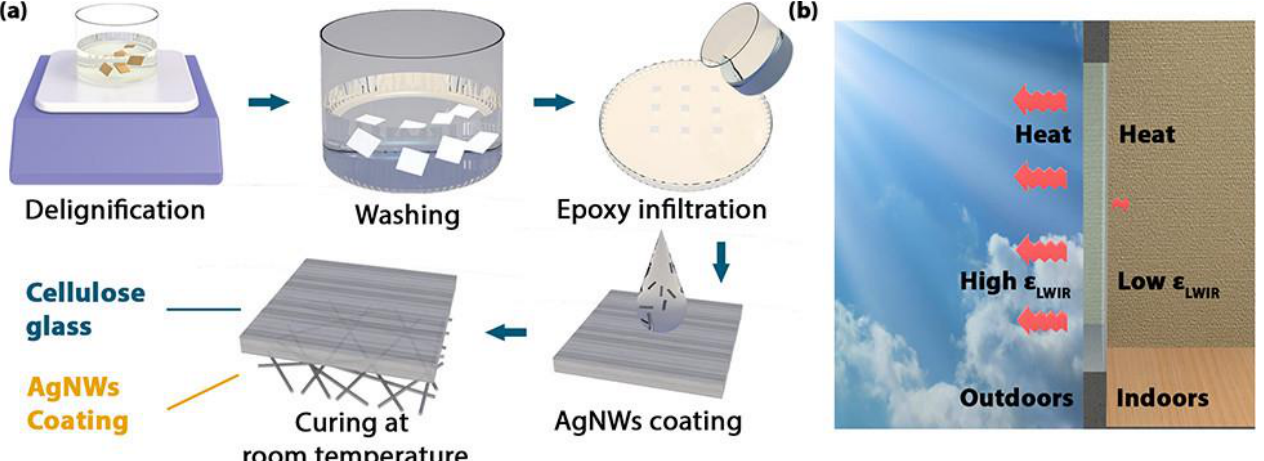
Figure 27. ( a ) Schematic manufacturing procedures of the radiative cooling transparent bamboo; ( b ) schematic demonstration of the working mechanism of the radiative cooling transparent bamboo. AgNWs = silver nanowires; ε LWIR = long-wavelength infrared emissivity. Reprinted with permission from [43], copyright 2021, American Chemical Society.